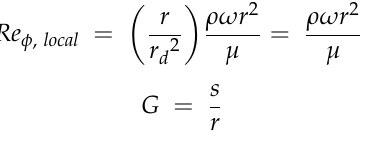
Table 1. Theoretical values of the flow quantities at different operating speeds near the rotating disc boundary layer.